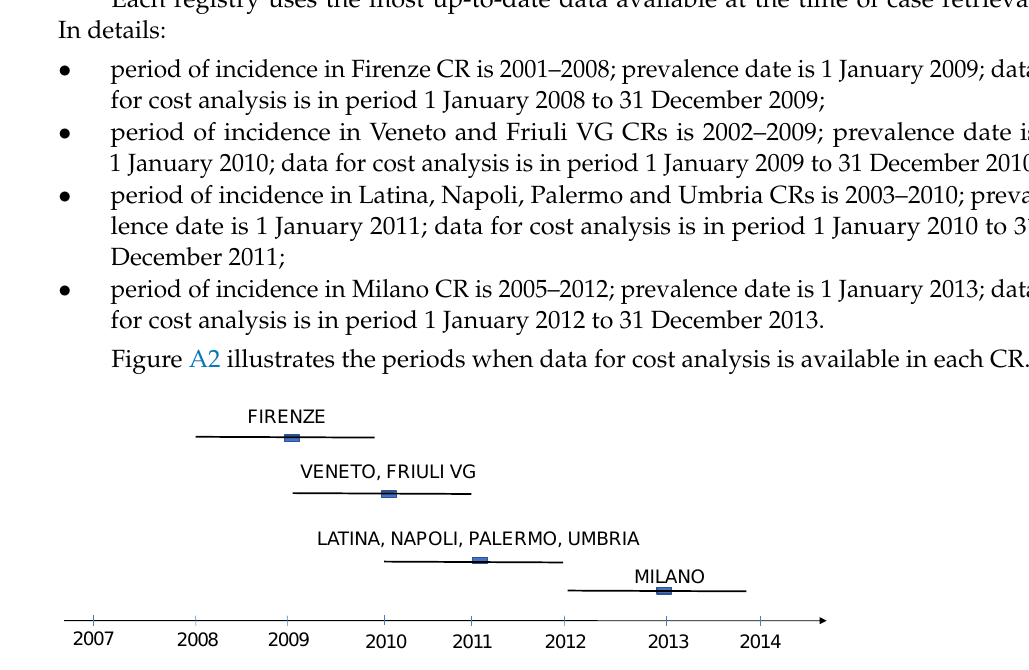
Figure A1. Phase-of-care study design.